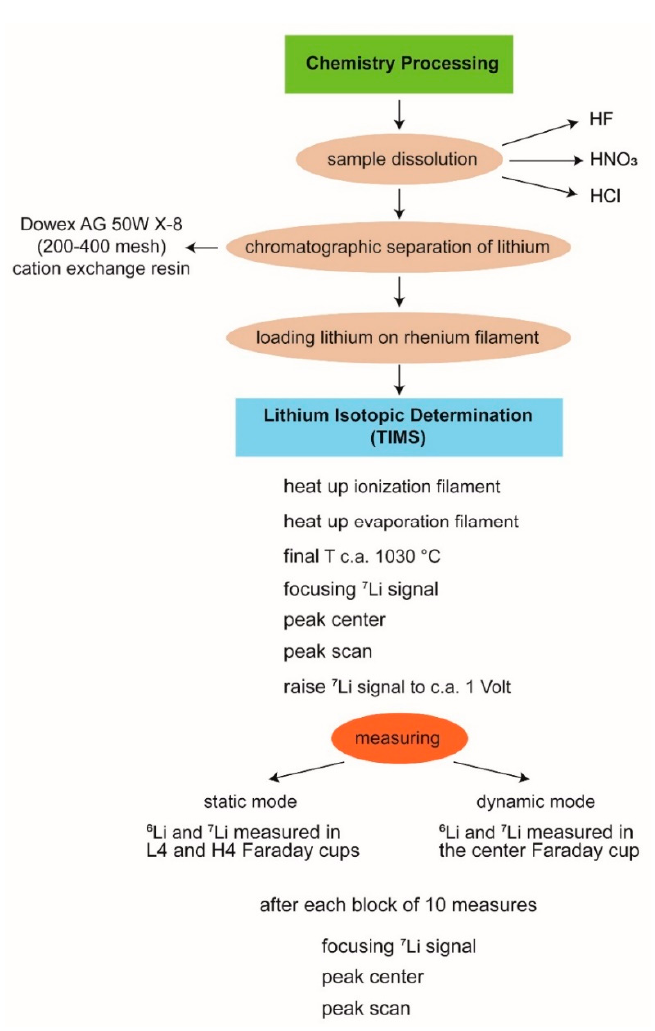
Figure 7. Flow-chart summarizing the procedures adopted for measuring the 6 Li / 7 Li isotope ratios.